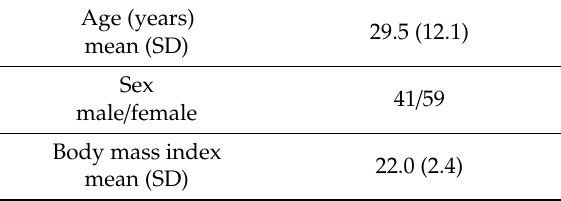
Table 1. Information about our sample.